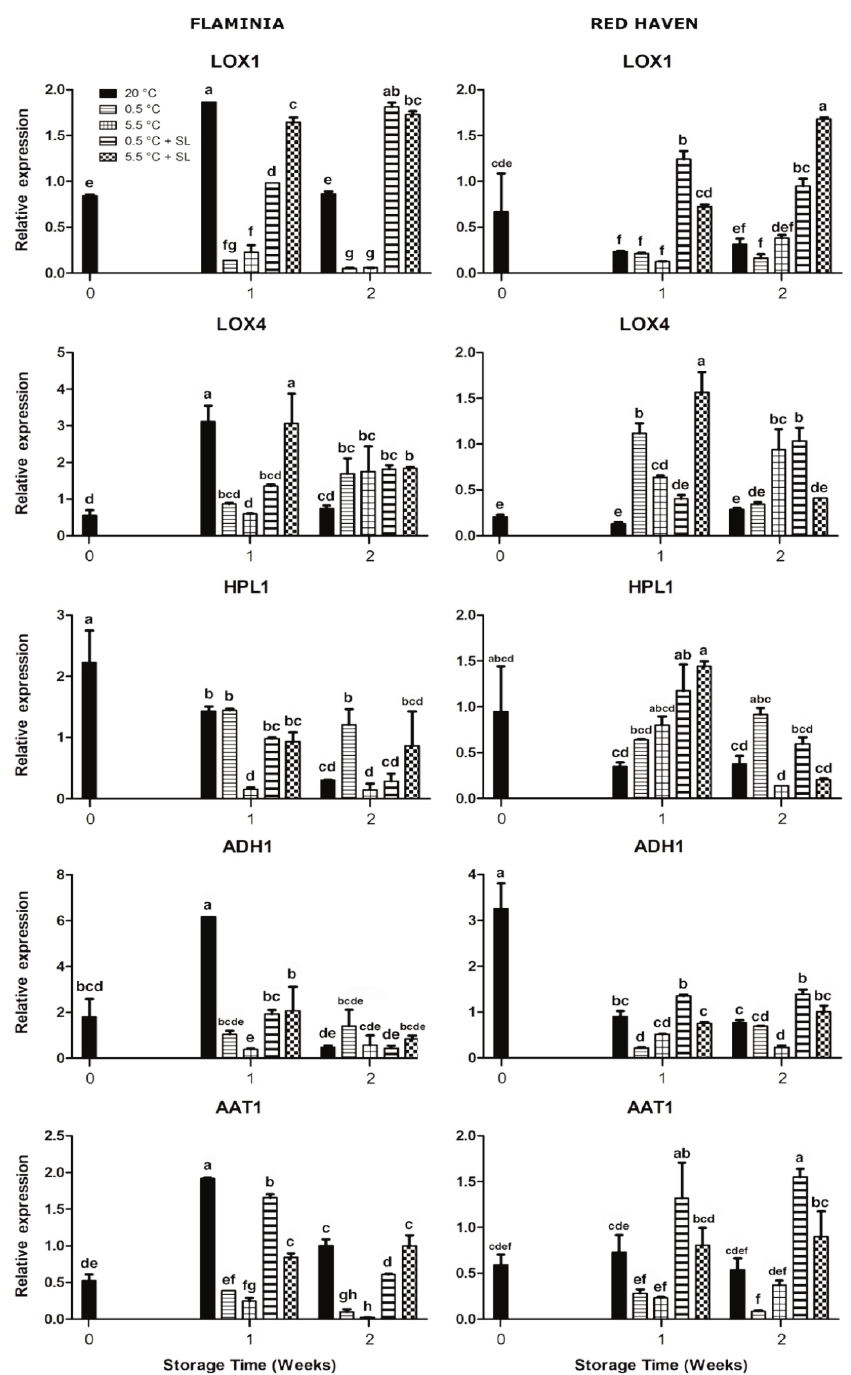
Fig. 4 ­ RT­qPCR analysis of selected LOX pathway­related genes. Mesocarp samples (cv. Flaminia, left panel; cv. Red Haven, right panel) were analysed at harvest (0), at the end of 1 and 2 weeks of cold storage at 0.5 and 5.5°C, and after three additional days of shelf life (0.5 and 5.5°C + SL). Samples kept at 20°C represent the room temperature control. The average value of three biologi­ cal replicates is reported with bars representing SD. Letters indicate the results of Tukey's Honest Significant Difference (HSD) post hoc test, performed independently for each